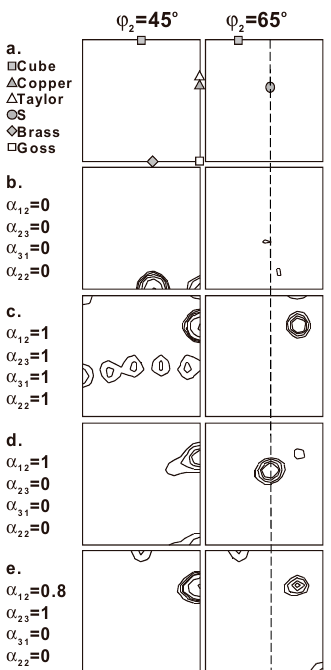
Figure 2. Relationship between the effective coefficient α ij and stabilities of the main rolling texture components in aluminum at 95% rolling reduction simulated by the RS model based on 936 initial random orientations [17]. ( ε 33 = − 3.0, i.e., 95% reduction; simulation steps Δε 33 = 0.001; orientation distribution functions (ODF) φ 2 = 45° and φ 2 = 65° sections; density levels: 5, 10, 20, 40, 80 and 160). ( a ) Orientation position of texture components; ( b ) stable brass and Goss textures at α 12 = α 23 = α 31 = α 22 = 0; ( c ) stable Taylor texture at α 12 = α 23 = α 31 = α 22 = 1; ( d ) stable S texture at α 12 = 1 and α 23 = α 31 = α 22 = 0; ( e ) stable copper and cube textures at α 12 = 0.8, α 23 = 1 and α 31 = α 22 = 0.